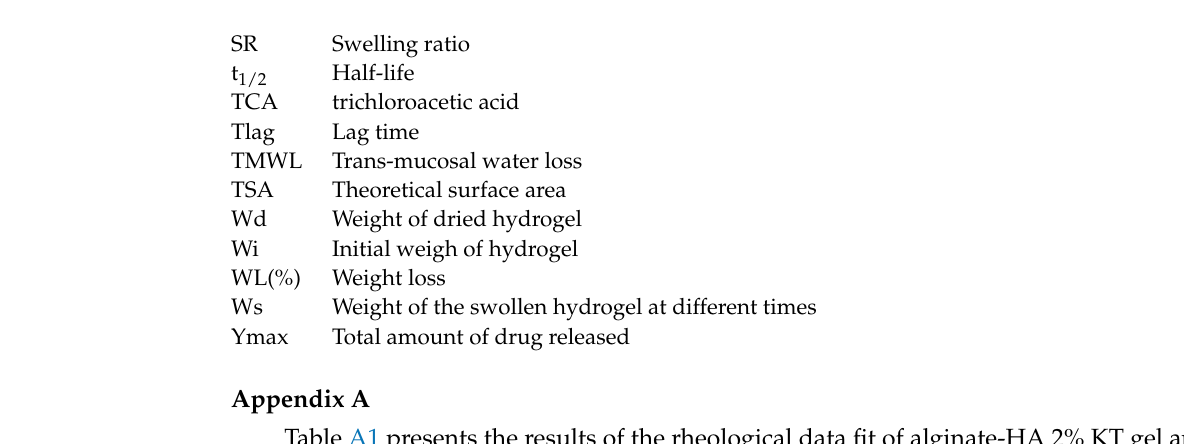
Table A1. Results of rheological data fit in different mathematical models.